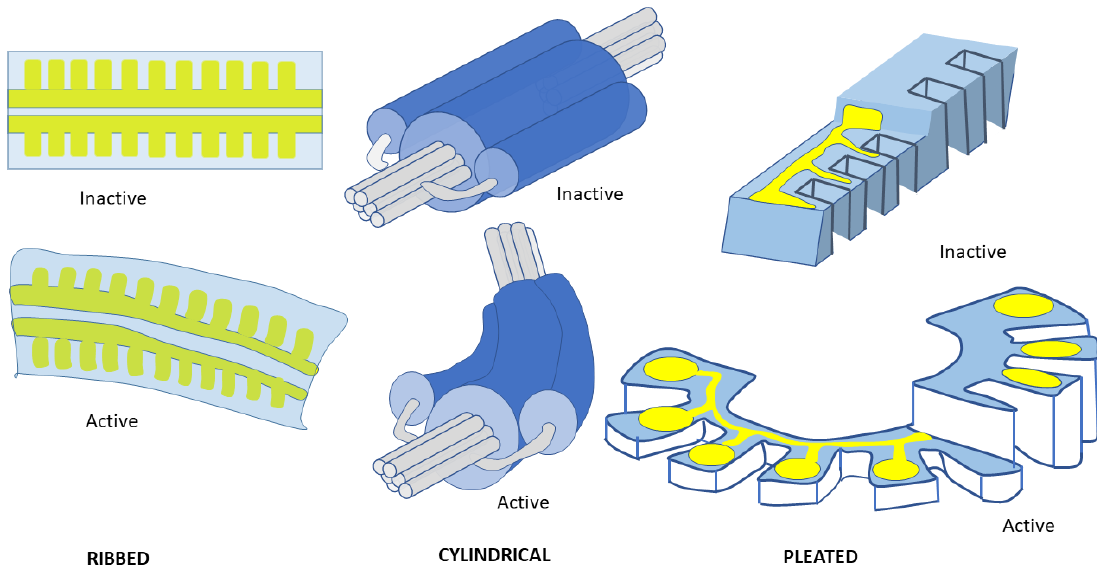
Figure 2. Ribbed, cylindrical, and pleated FEA, based on [7].